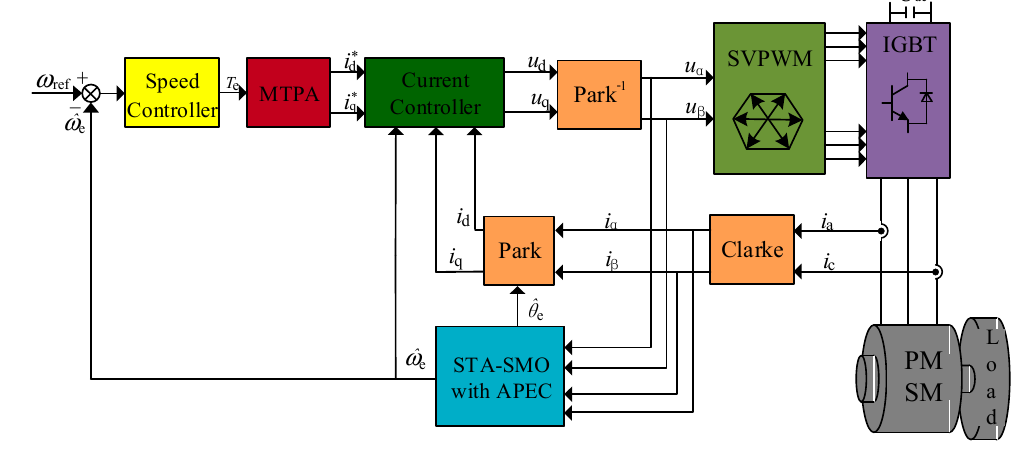
Figure 5. Control system structure diagram.